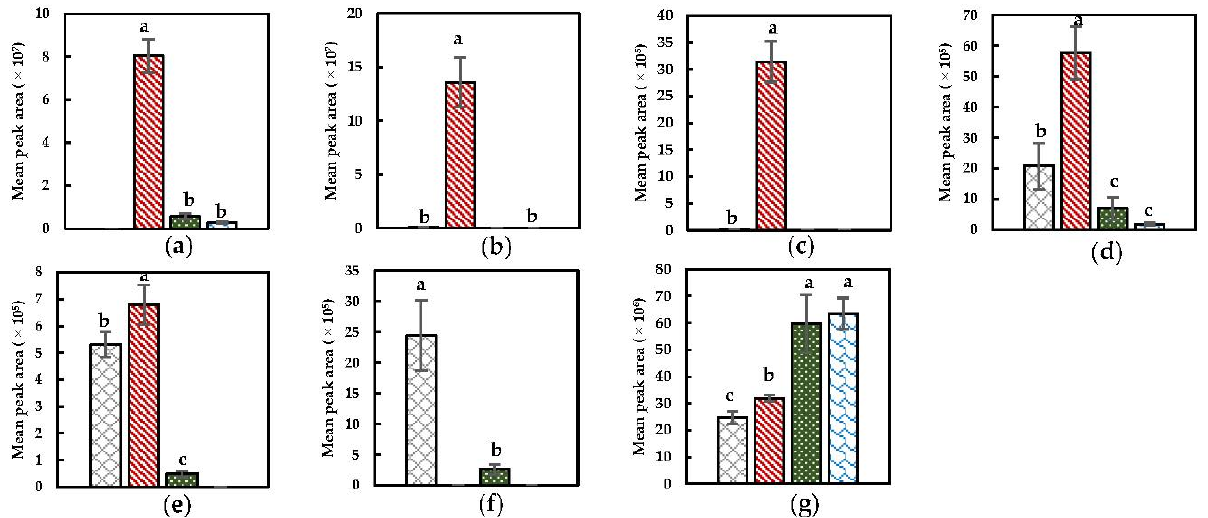
Figure 2. Specific compound plots of selected discriminant sulfurous compound and nitriles in the headspace of differently pretreated Brussels sprouts (( ) NoPT, ( ) Mix + Heat, ( ) PEF + Heat + Mix, and ( ) Heat + Mix). ( a ) Dimethyl disulfide; ( b ) dimethyl trisulfide; ( c ) methyl (methyl ‐ thio)methyl disulfide; ( d ) 4 ‐ (methylthio) butanenitrile; ( e ) benzyl nitrile; ( f ) hexanenitrile; ( g ) 2 ‐ bu ‐ tenenitrile. Statistically significant differences are designated by different letters ( 𝑝 < 0.05, 𝑛 = 12). In contrast to sulfurous compounds, nitriles (e.g. , hexanenitrile) were already mark ‐